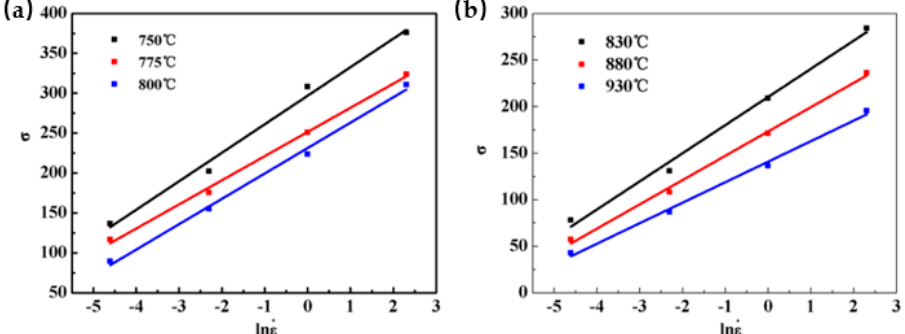
Figure 4. Relationship between σ and ln έ at different deformation temperatures: ( a ) α + β region; ( b ) β region.